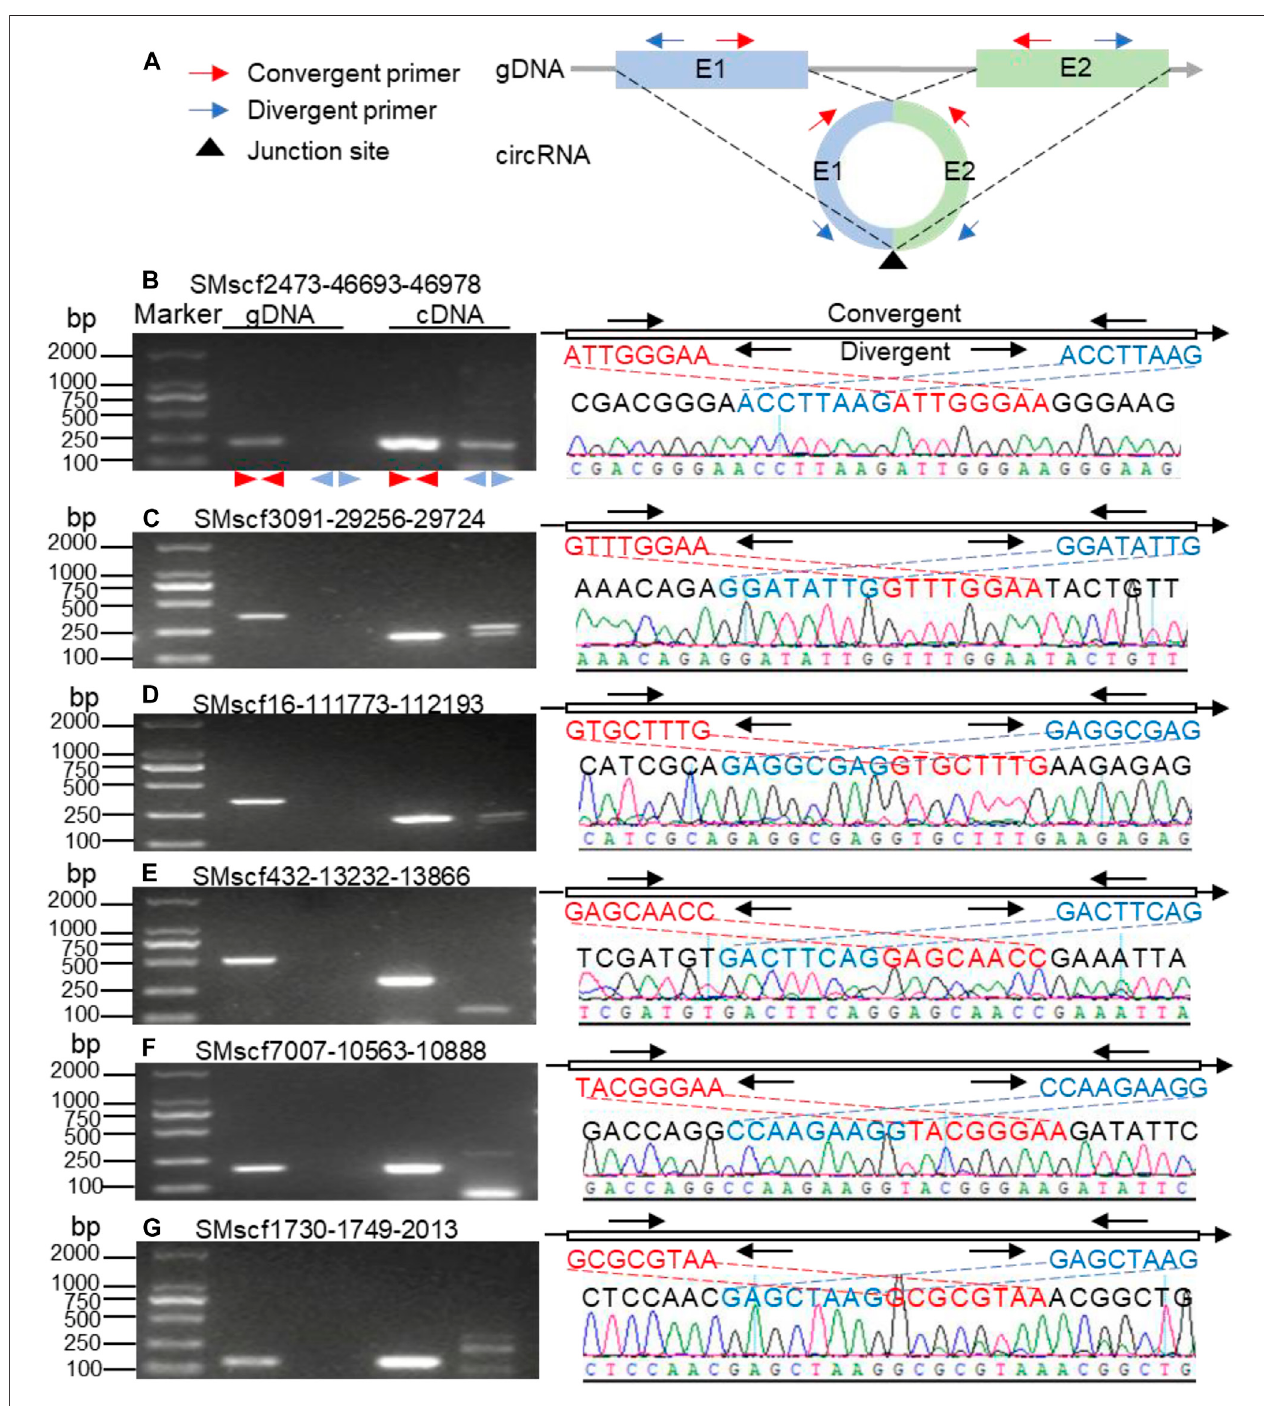
FIGURE 2 | Validation of circRNAs identi fi ed in S. miltiorrhiza . (A) Schematic representation of the validation strategy. Colored rectangles and gray lines represent exons and introns, respectively. E1, exon 1, E2, exon 2. The red and blue arrows represent convergent and divergent primers, respectively. The black triangle under the circle indicates the junction site for circularization. The dashed lines show the position of the junction sites on the genomic DNA. As demonstrated in the fi gure, both convergentprimerpair (red) and divergent primerpair (blue) areexpected toproduce PCRproducts usingthecDNAofthecircRNA asatemplate. Incontrast,only theconvergentprimerpairisexpectedtoproducePCRproductsusinggenomicDNAasatemplate.However,duetothepresenceoftheintron,thePCRproductsofthe circRNA and genomic DNA are different for the same convergent primer pair. (B-G) the electrophoretic gel picture of the PCR results. The type of template for PCR is shown on the top of each gel picture. The type of primer is shown at the bottom of each gel. gDNA, genomic DNA; cDNA, complementary DNA; “ ” , convergent primer pair; “ ” , divergentprimerpair.TherightpartineachpanelcomparesthesequencesaroundthejunctionsiteswiththoseobtainedfromSangersequencing.The